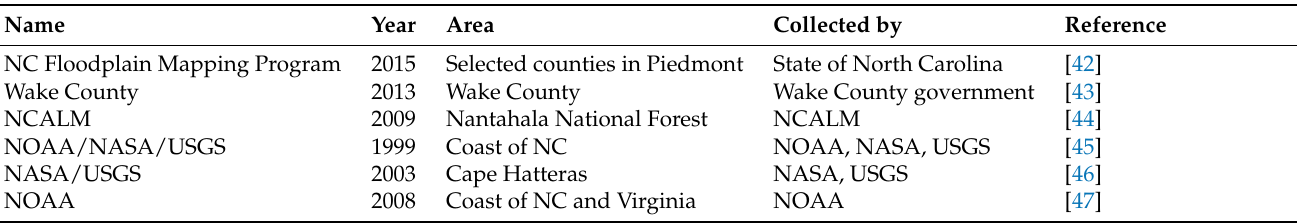
Table 1. Overview of the six airborne lidar datasets used for demonstrating density variations. All datasets are for parts of North Carolina (NC), USA.